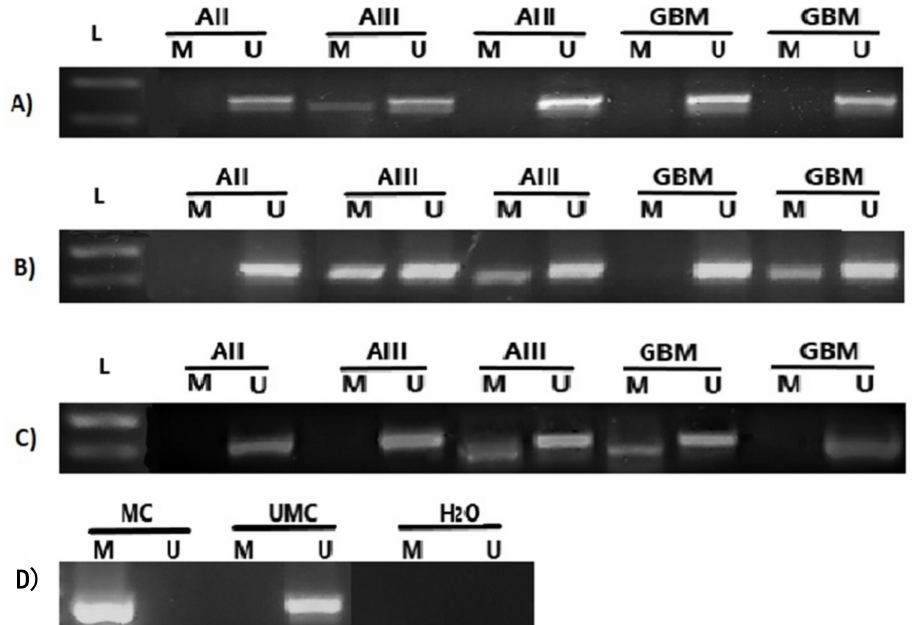
Figure 2. Methylation-specific PCR analysis for ( A ) GSK3 β , ( B ) DKK1 , and ( C ) DKK3 promoter in astrocytic brain tumors grade II–IV. The presence of a visible PCR product in lanes marked M indicates the presence of methylated promoters, the presence of a product in lanes marked U indicates the presence of unmethylated promoters; ( D ) methylated human control (MC) was used as positive control for methylated reaction, unmethylated human control (UMC) was used as positive control for unmethylated reaction, and water served as negative control. L–standard DNA 50 bp ladder